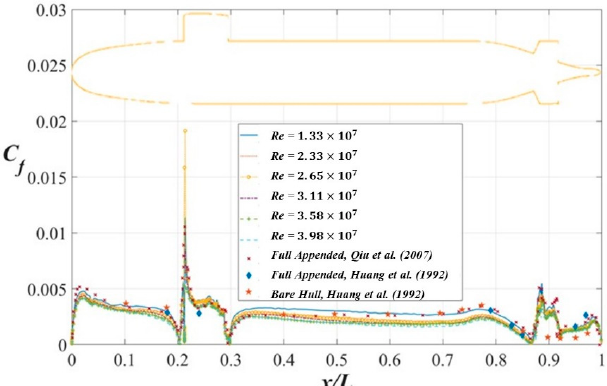
Figure 9. Comparisons of simulated and experimental friction coe ffi cients C f along the top meridian line of the SUBOFF model with full appendages under different Re conditions. J. Mar. Sci. Eng. 2020 , 8 , x FOR PEER REVIEW